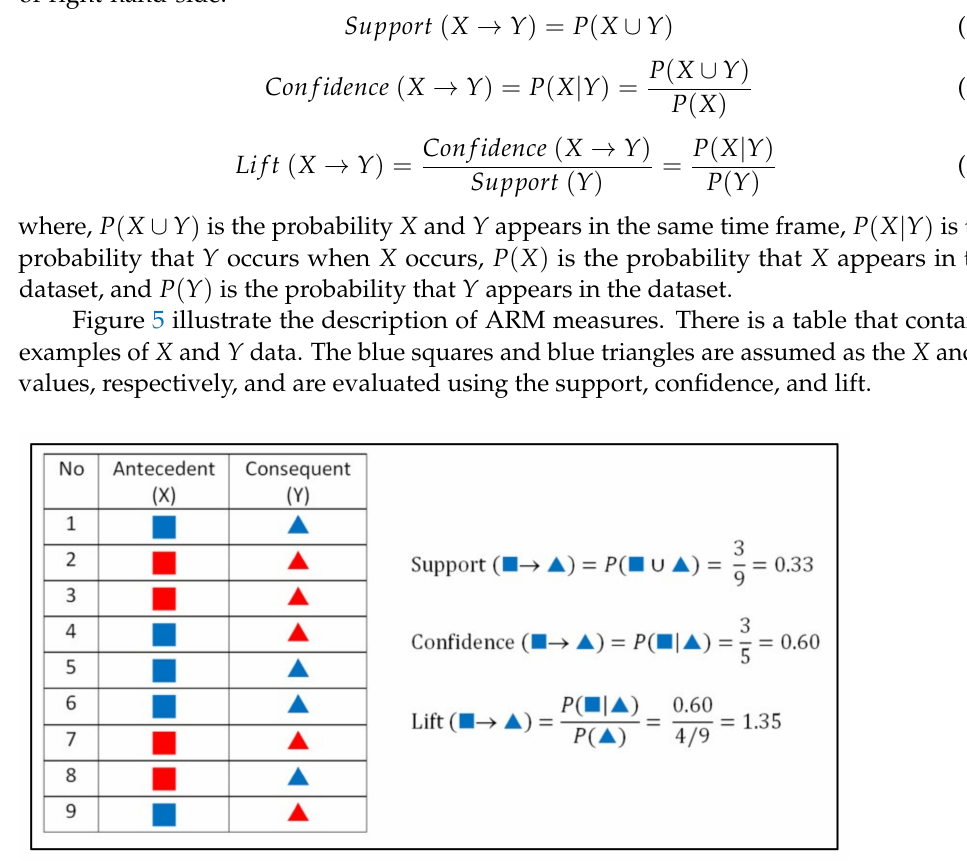
Figure 5. The descriptions of ARM